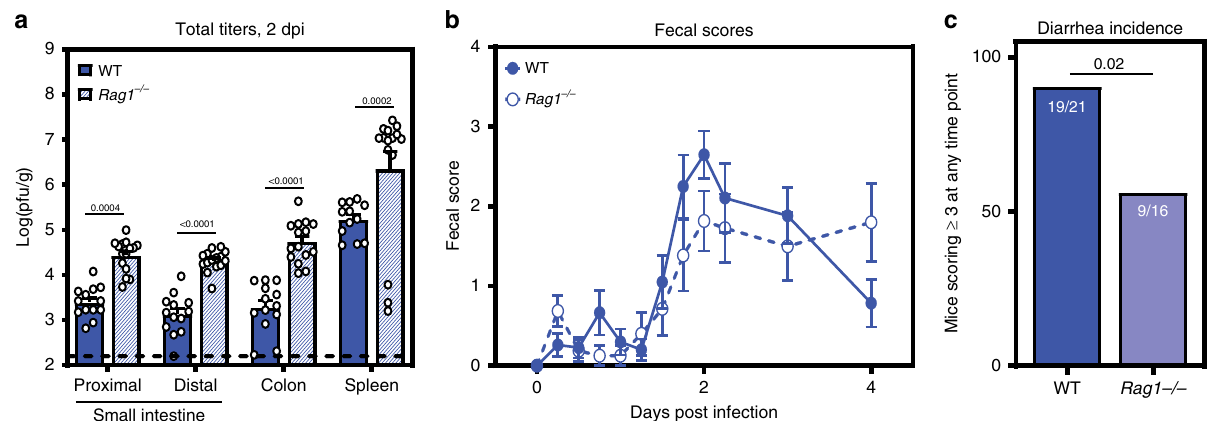
Fig. 6 MNV-1 infected Rag1 − / − pups show decreased diarrhea but increased viral titers. a Groups of 3-day-old BALB/c- Rag1 − / − pups (blue stripes) were infected with 10 8 TCID 50 units MNV-1 by oral gavage. At 2 dpi ( n = 15), total viral titers were determined in the indicated segments of the intestinal tract and spleen by plaque assay, and compared with those of wild-type BALB/c pups (solid blue). b , c Additional BALB/c- Rag1 − / − pups ( n = 16, open circles) were infected with 10 8 TCID 50 units MNV-1 by oral gavage and monitored for fecal consistency over a 5-day time course by palpating their abdomens. Fecal scores ( b ) and diarrhea incidence ( c ) were compared with those in wild-type BALB/c pups (solid blue). Error bars denote standard errors of mean in all fi gures. P values were determined using two-way ANOVA with corrections for multiple comparisons for viral titers. For incidence, P values were determined using a Mantel-Cox test. Source data are provided as a Source data fi